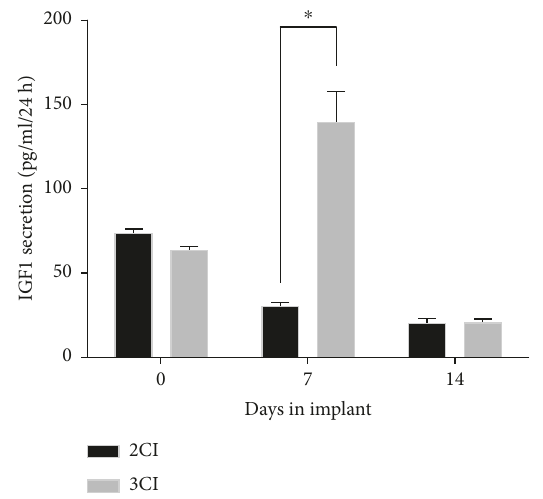
Figure 4: Secretion of IGF1 in ADSCs cultured on the alginate/bovine cartilage matrix sca ff old. Secretion of the IGF1 protein to the culture medium in nontransduced (2CI) and transduced (3CI) ADSCs after 7 and 14 days in the 3D system. A signi fi cant di ff erence was observed at day 7 of culture in the implant 3CI compared with 2CI ( ∗ p < 0 05